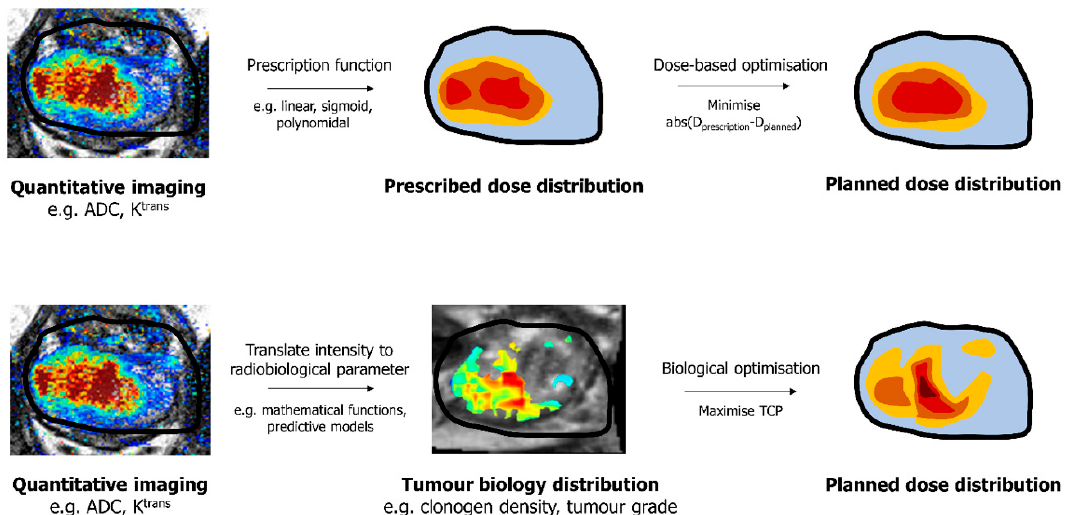
Figure 1. Pathways for optimising planned dose distribution based on the desired dose prescription ( top ) and based on the desired endpoint ( bottom ) using the same quantitative imaging data.